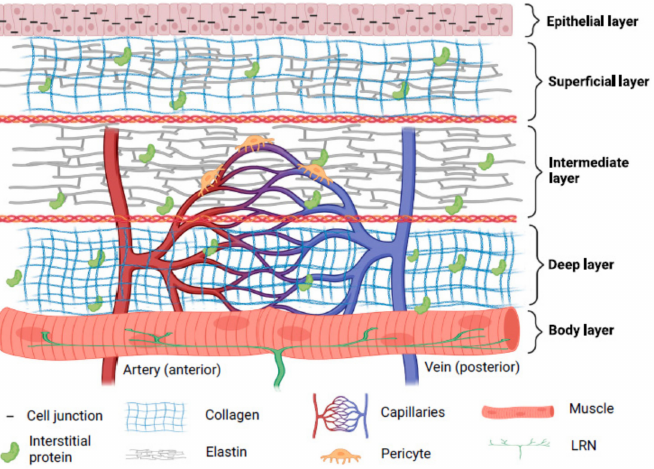
Figure 1. Structure of human vocal fold. Created with BioRender.com (accessed on 24 October